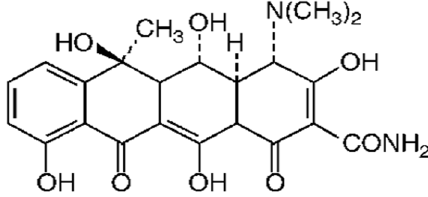
Fig. 1 Structure of oxy-tetracycline (Li et al. 2008)